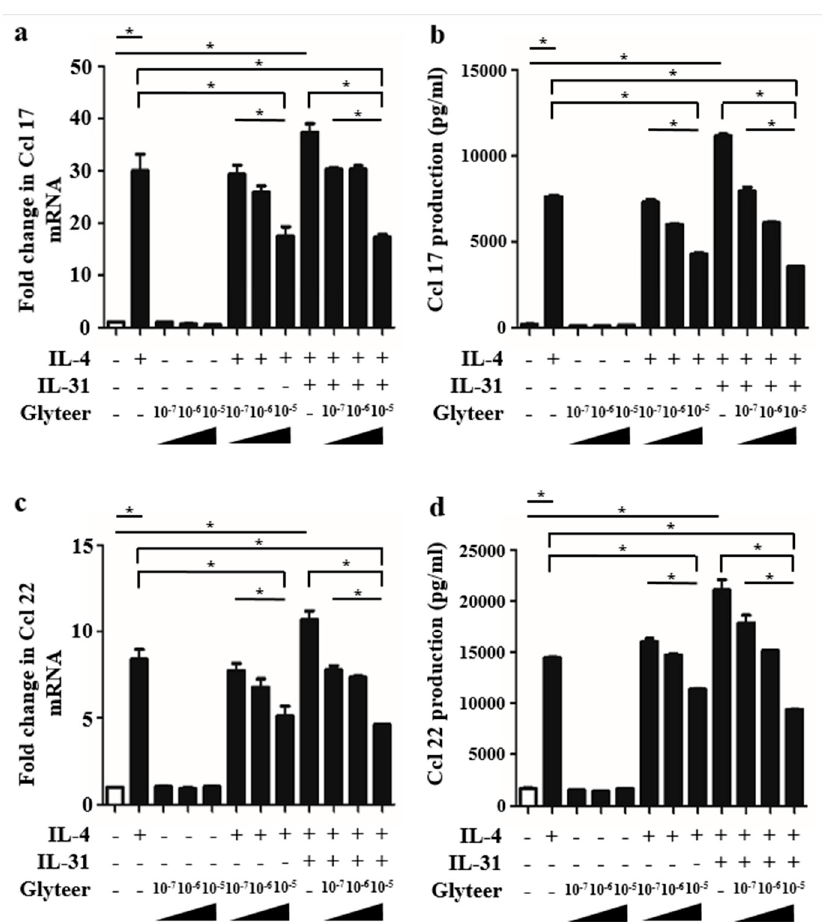
Figure 4. Glyteer impaired IL-4 with IL-31-induced Ccl 17 and Ccl 22 production in BMDCs. ( a – d ) Data are expressed as mean ± standard error of the mean (S.E.M.); n = 3 for each group; * p < 0.05. Expression of Ccl 17 ( a ) and Ccl 22 ( c ) mRNA in BMDCs stimulated with or without IL-4 (10 ng / mL), IL-31 (100 ng / mL), and Glyteer (10 − 7 , 10 − 6 and 10 − 5 %) for 48 h and production of Ccl 17 ( b ) and Ccl 22 ( d ) in the culture supernatant were measured.